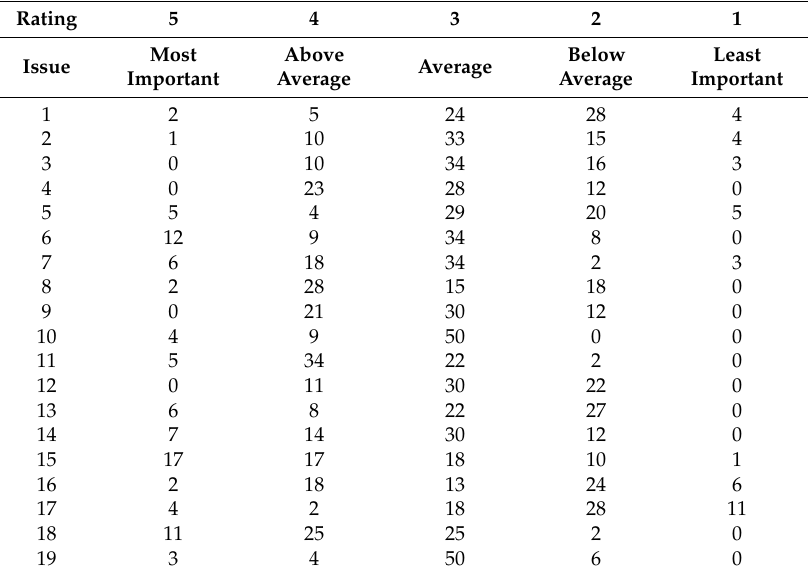
Table 18. Data collected through Survey.